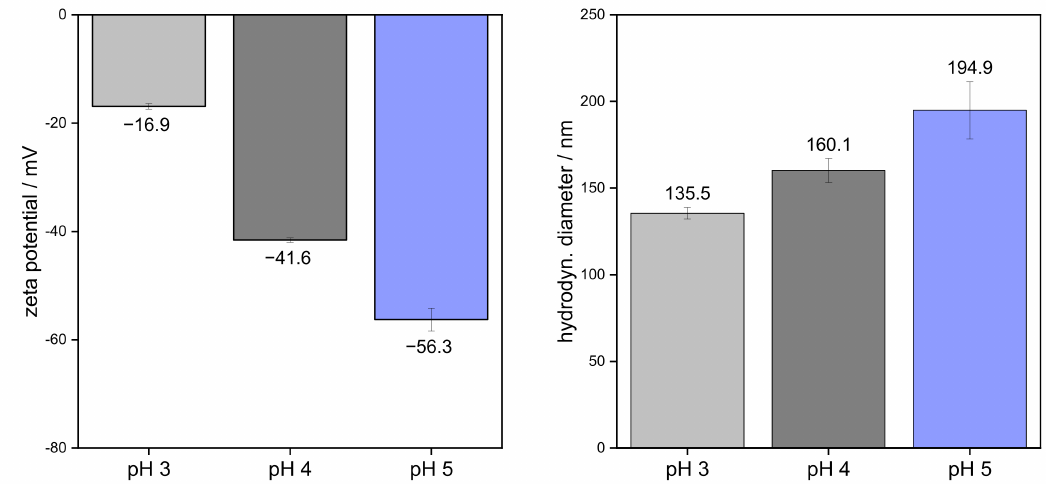
Figure 1. Zeta potential and hydrodynamic diameter of 0.1 wt% sugar beet pectin in aqueous solutions at different pH